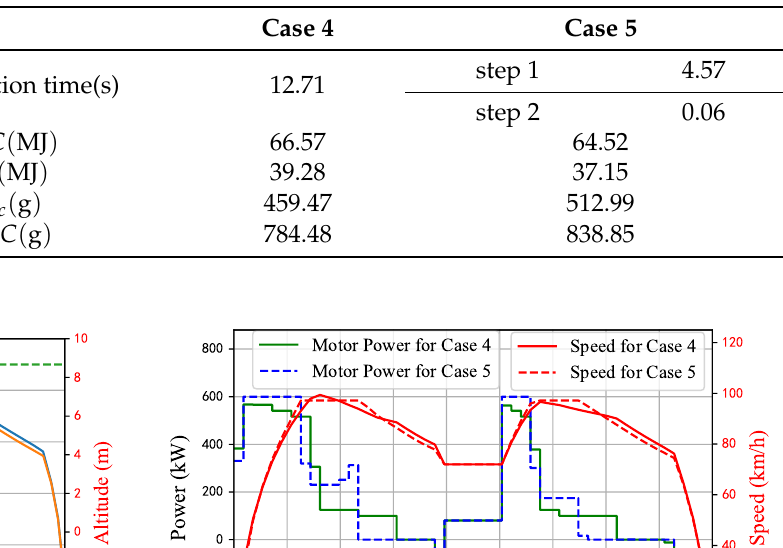
Table 6. The performance comparison between co-optimization (Case 4) and sequential optimization (Case 5) with speed limit and gradients.